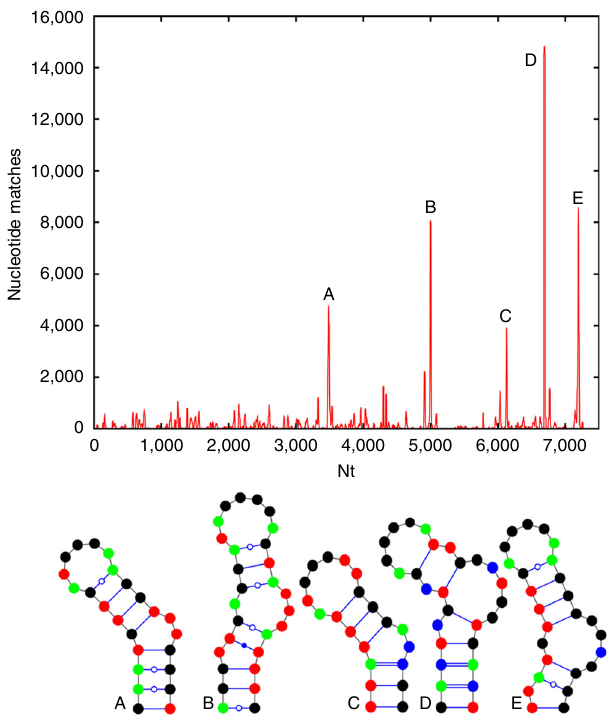
Fig. 5 Conservation across the HPeV genus. We used the selected HPeV1 library to derive a Bernoulli plot for a representative of the HPeV3 group (GQ183026), which is most distal from the HPeV1 group from the point of view of VP1-VP4 conservation (Supplementary Fig. 6). The number of nucleotide matches of the HPeV3 genome to the selected HPeV1 library is remarkable: with up to 15,000 nucleotide matches for higher peaks and smaller peaks between 1000 and 2000, as opposed to a maximum of 8000 for the higher peaks and 1000 – 3000 for the lower peaks in HPeV1, indicating that a similar recognition motif is likely to occur also in